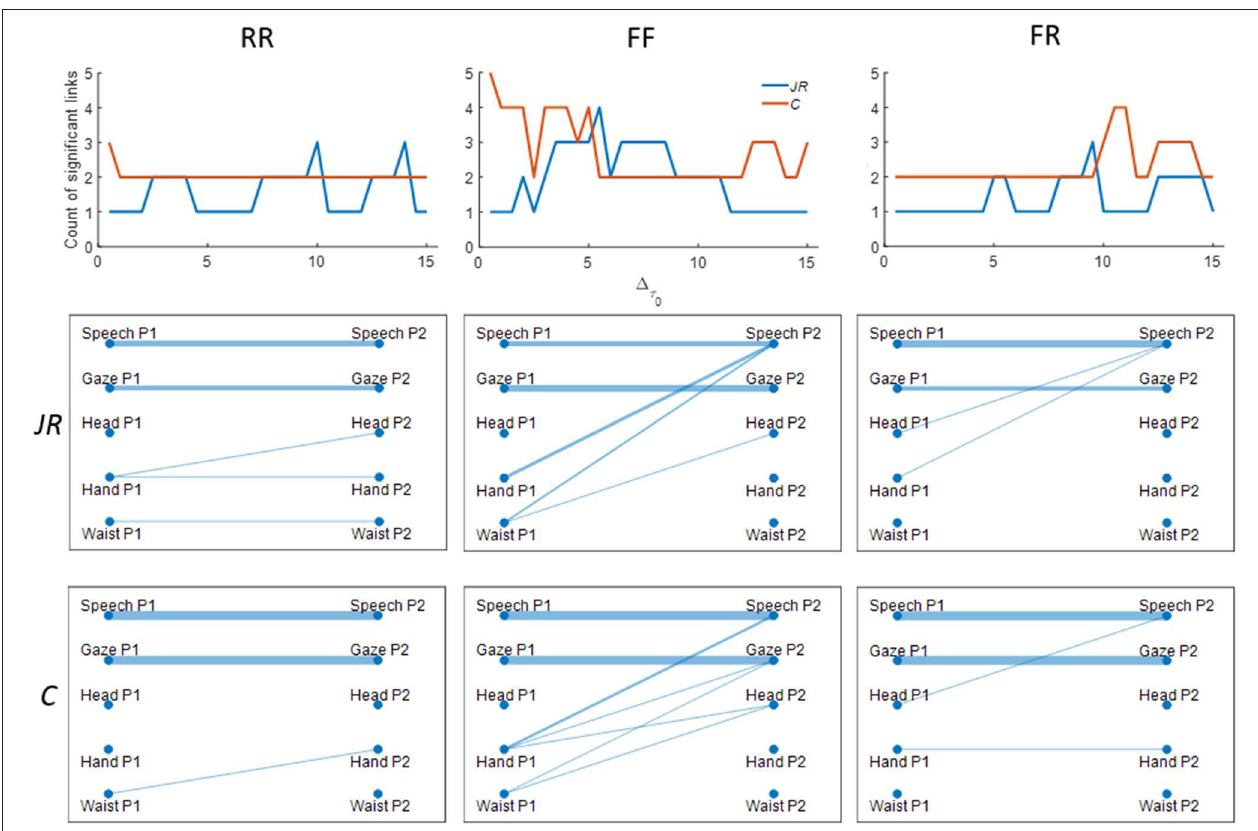
FIGURE 4 | Figures summarizing graph density and topology for interpersonal data calculated using TDSLMAX. Columns correspond to the three levels of hand restraint placed on the interacting pairs. The first row shows the count of significant links as a function of the TDS similarity threshold parameter ( 1 τ JRQA-based and cross-correlation-based measures. The second and third row are networks showing the significant links between person one (P1) and person 2 (P2) identified by the JRQA-based and cross-correlation-based methods. The thickness of the lines in the graphs indicate the proportion of times that link was identified as significant over all values of 1 τ 0